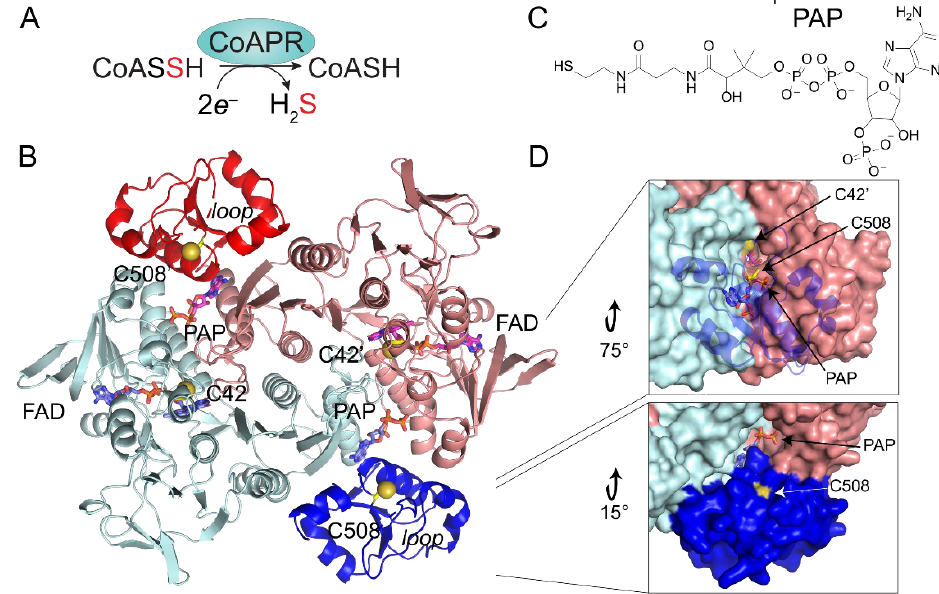
Figure 5. X-ray crystallographic analysis of E. faecalis CoAPR. ( A ) Reaction catalyzed by CoAPR; FAD and pyridine nucleotide cofactors are not shown. ( B ) Ribbon diagram of the CoAPR homodi- mer, with one subunit shaded light blue (CDR domain)/blue (sulfurtransferase domain) and the